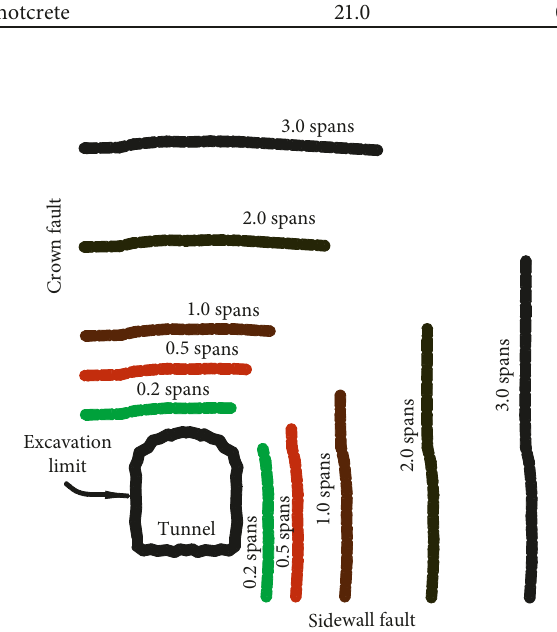
Figure 4: Crown and sidewall faults with different distances from tunnel limit.